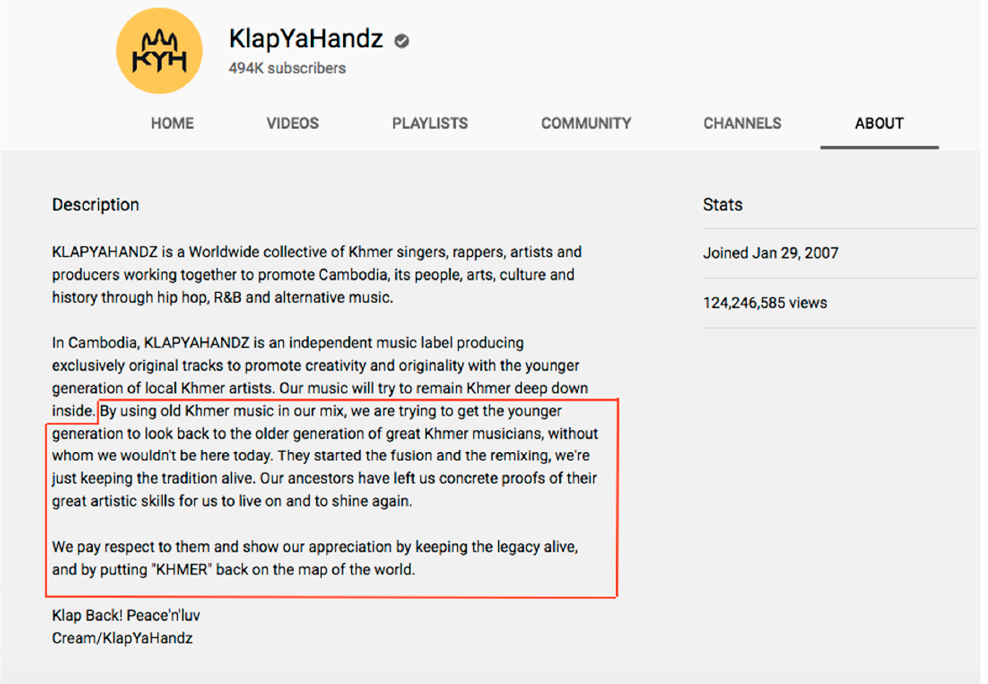
Figure 4. KlapYaHandz: A screenshot of the YouTube page where Sok “Cream” Visal analyzes the hip hop his company produces through the Cambodian–Buddhist ethics of ra ṃ l ẏ k gu ṇ .